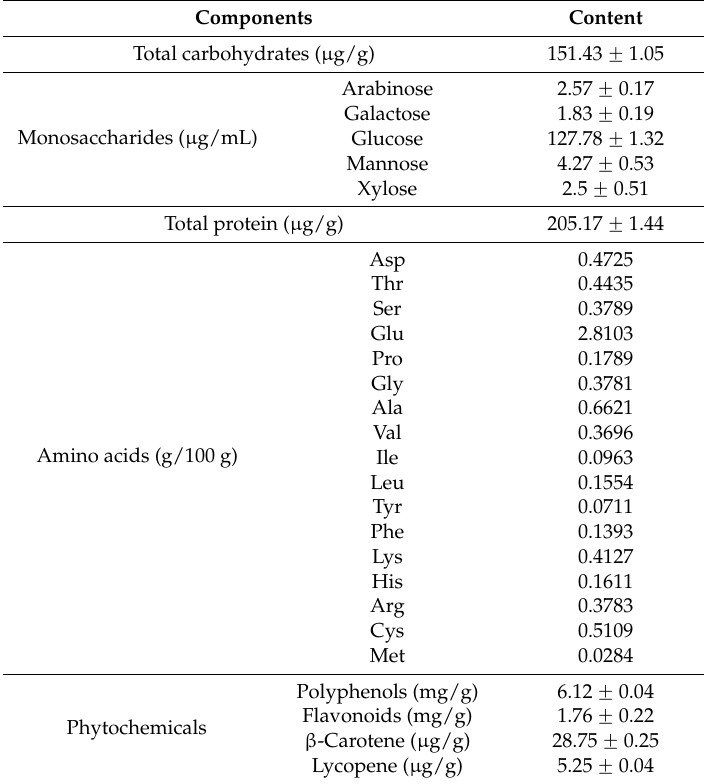
Table 1. Carbohydrates, monosaccharide, total protein, amino acid, and selected phytochemical content in L. edodes ethanolic